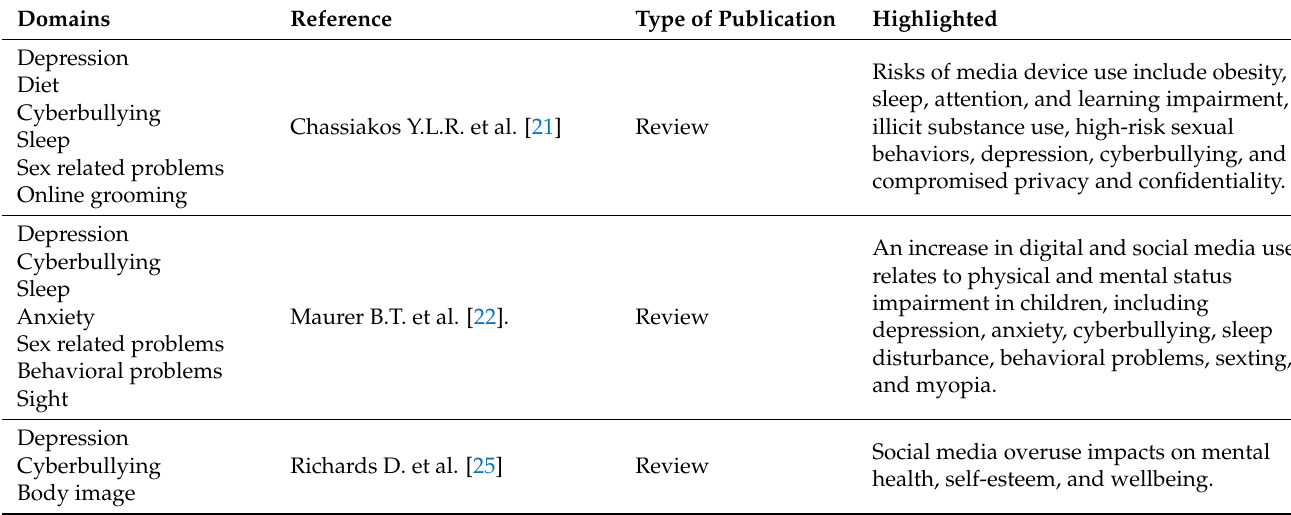
Table 4. Social media and